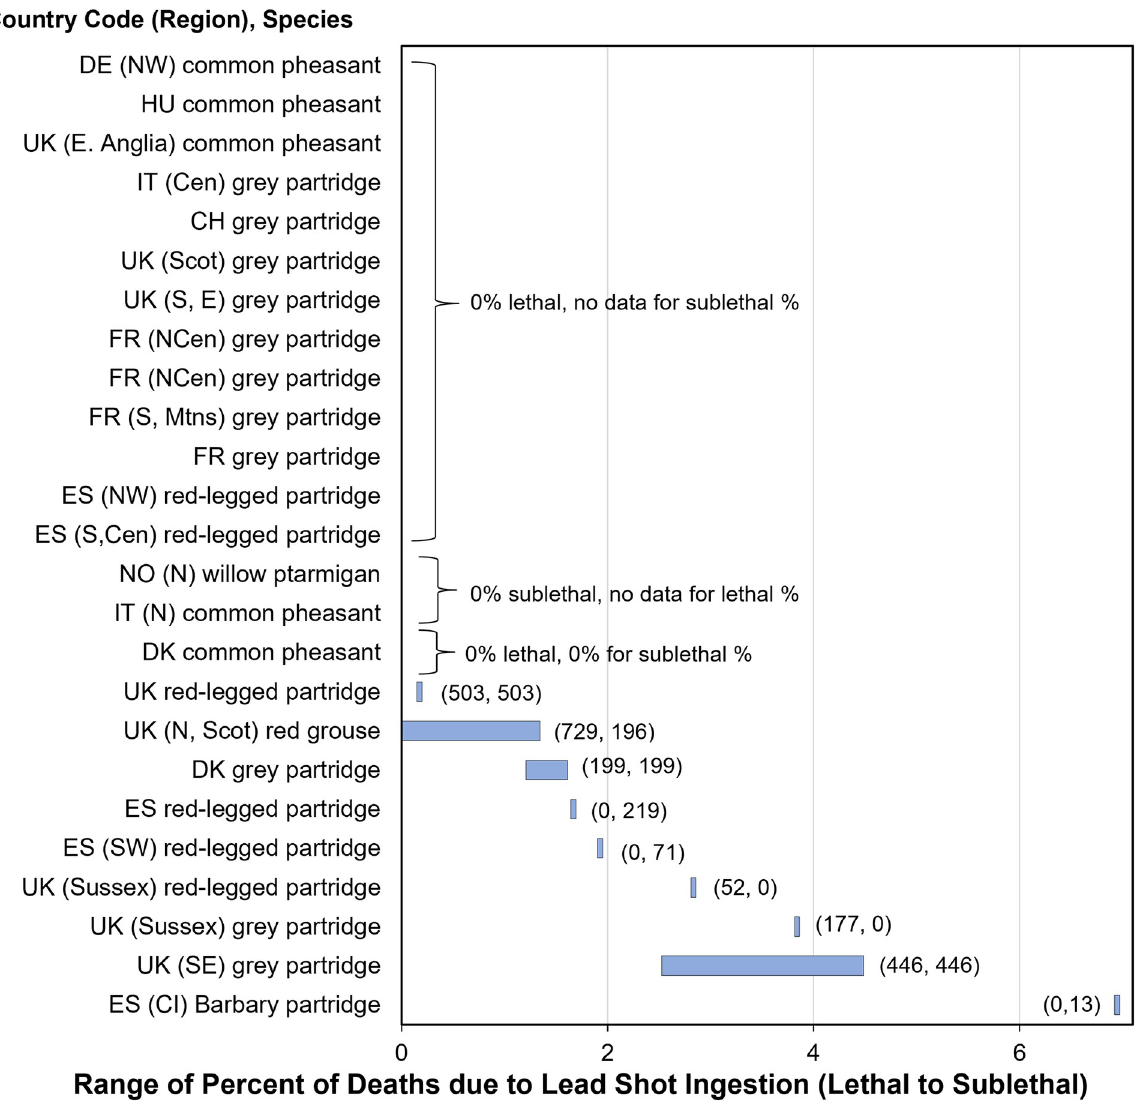
Fig 1. Estimated range of percentage of deaths due to lead shot ingestion in gallinaceous birds. Bars show range, where lower end is based on poisoning diagnosis as lethal and upper end includes all possible deaths ultimately from sublethal exposure based on ingesting one shot or subclinical liver concentrations. Pipe symbols (short bars) represent one number because sublethal or lethal estimates were unavailable. Scot = Scotland, Cen = central, CI = Canary Islands. Other abbreviations are European country codes and, in parenthesis, compass directions. Sample sizes of estimates (lethal, sublethal) are shown in